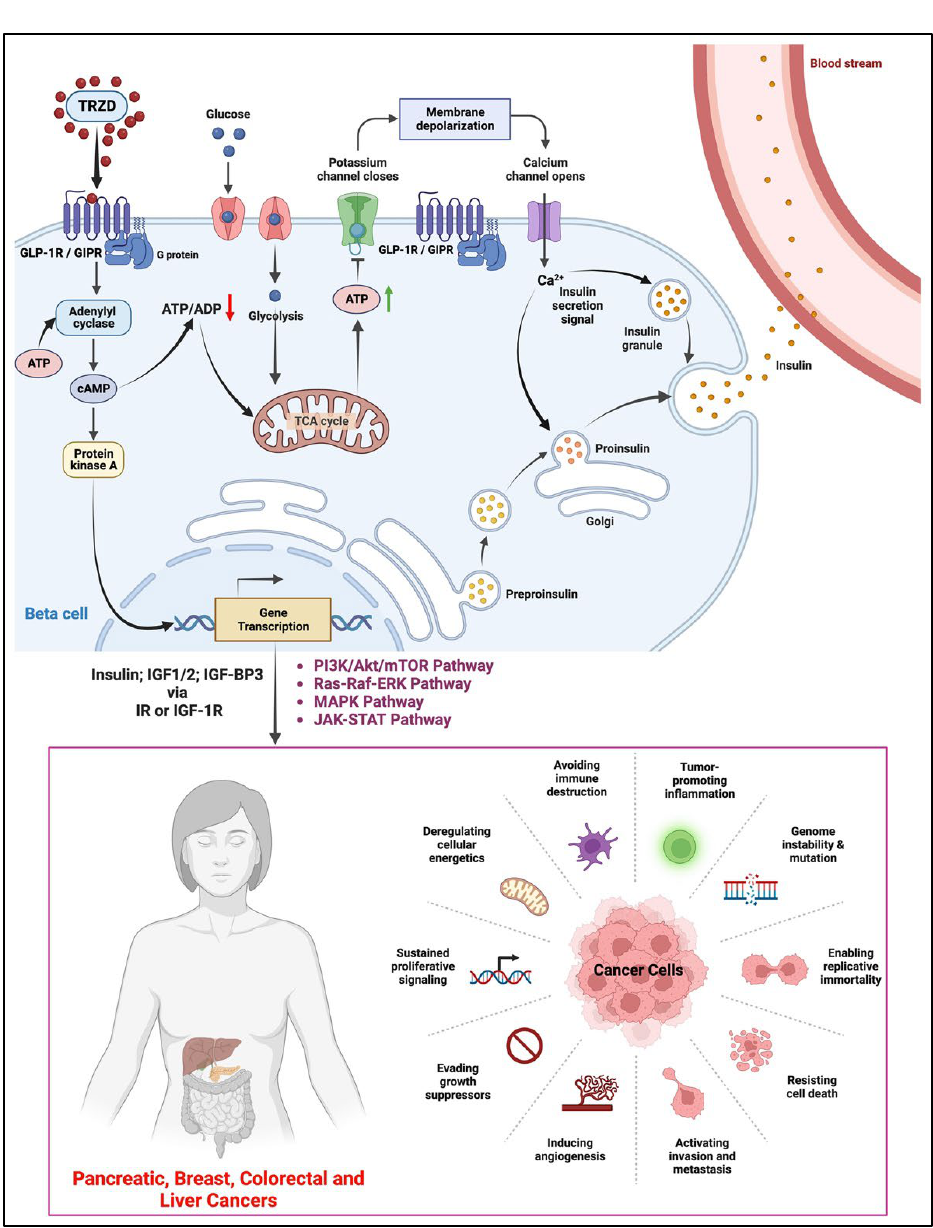
Figure 2. Possible pro-oncogenic effect of tirzepatide (TRZD) on the pancreas, breast, colorectal, and liver cancers. TRZD, possibly via GLP-1R or GIPR activation, leads to intracellular Ca 2+ -dependent release of insulin from the pancreatic β -cells. The GLP-1R activation can also lead to protein kinase A-dependent gene transcription leading to the synthesis and release of insulin-like growth factor 1 or 2 (IGF 1/2) and insulin-like growth factor binding protein 3 (IGF-BP3). Insulin and IGF 1/2 via the insulin receptor (IR) and the IGF receptor 1 (IGF-1R) in turn activate the PI3K/Akt/mTOR, Ras-Raf-ERK, MAPK, and JAK-STAT pathway, which supports several oncogenic and cancer progression traits such as resisting cell death, induction of angiogenesis, sustained proliferative signals, tumor inflammation, and activation of invasion and metastasis in target tissues (pancreas, breast, colorectum and liver). The black arrows indicate the pathway and flow of components involved in the pathway. The green upward arrow indicates an increase, while the red downward arrow indicates a decrease. Created with Biorender.com (accessed on 15 September 2022).